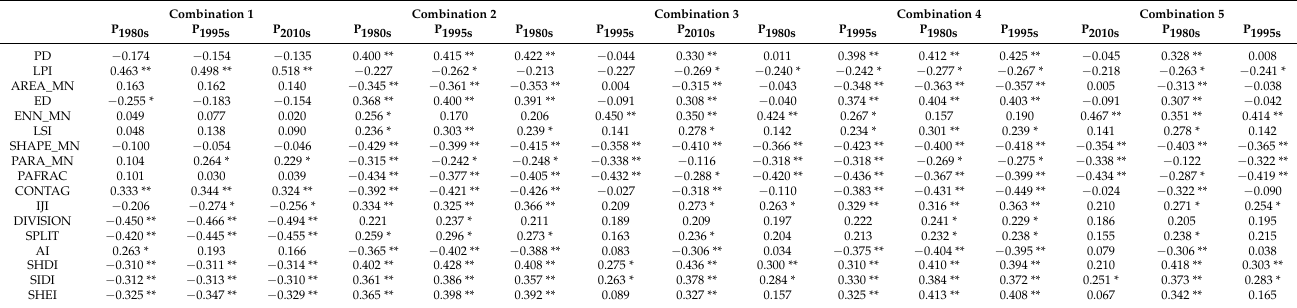
Table 6. The correlation between landscape metrics and sediment yield under five different